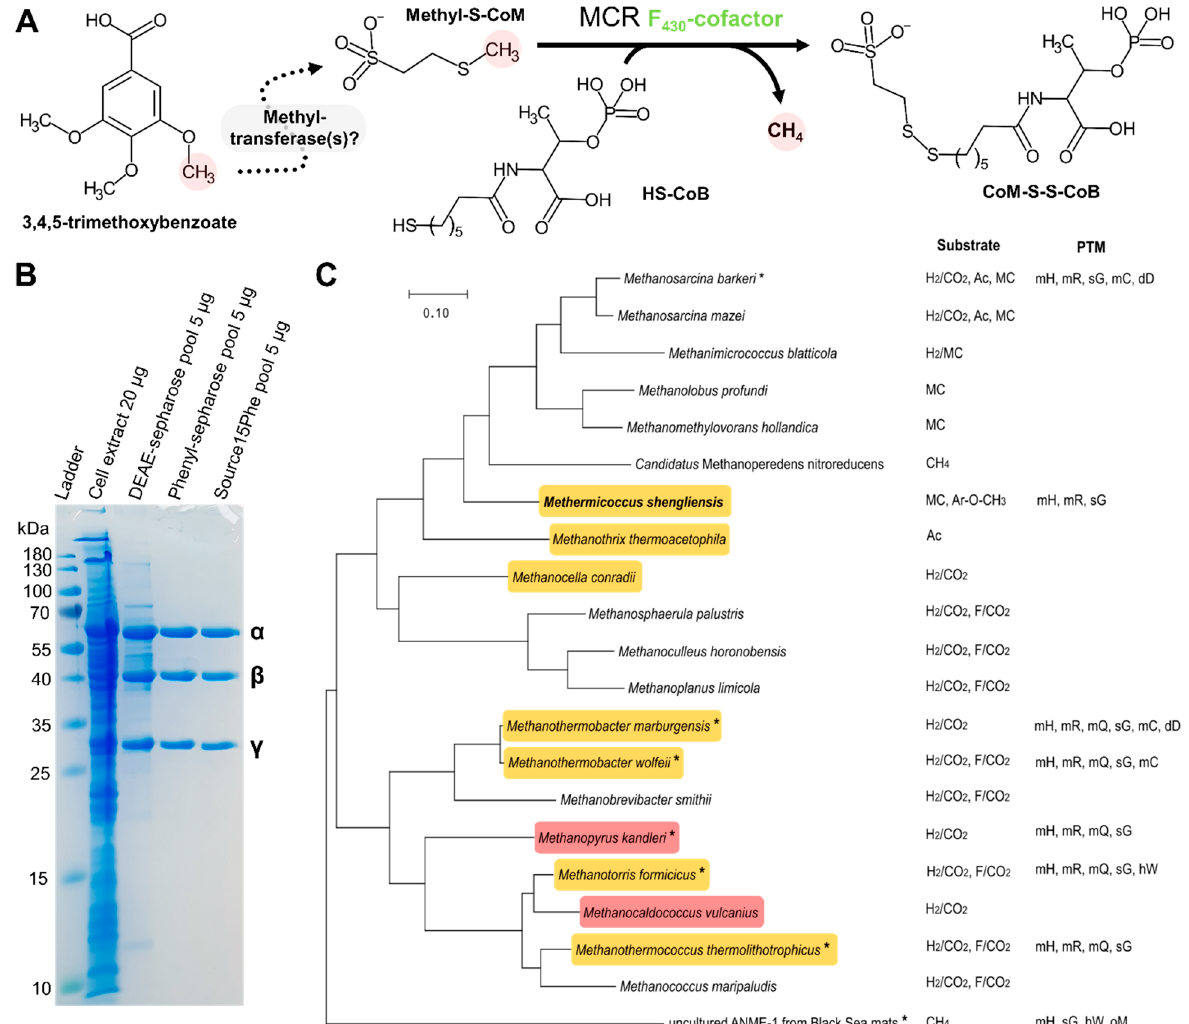
Figure 1. MCR metabolic function, purification, and phylogeny. ( A ) During methoxydotrophic growth, 3,4,5-trimethoxybenzoate (TMB) methyl-groups are transferred by an unknown mechanism to the central carbon metabolism of the methanogen. The methyl-group will be transferred onto HS-CoM and MCR will branch methyl-S-CoM to CoB-SH by a thiyl-radical based reaction catalyzed by its F 430 cofactor. The end products of the reaction are methane and the heterodisulfide made of HS-CoM and CoB-SH. ( B ) Purification profile on SDS-PAGE of MCR α , β and γ subunits from TMB-grown cells. ( C ) Phylogenetic tree of concatenated MCR generated with MegaX using the Maximum Likelihood method and JTT matrix-based model (see Materials and Methods). Orange and red backgrounds indicate thermophiles and hyperthermophiles, respectively. Structural information exists for the species with asterisks. Post-translational modifications (PTM) observed in the structures are shown: mH, N 1 -methylhistidine; mR, 5(S)-methylarginine; mQ, 2(S)-methylglutamine; sG, thioglycine; mC, S-methylcysteine; dD, didehydroaspartate; hW, 6-hydroxytryptophan in M. formicicus and 7-hydroxytryptophan in ANME-1; oM, oxidized methionine. Growth substrates are also indicated (Ac, acetate; F, formate; MC, methylated compounds; Ar-O-CH 3 , methoxylated compounds).